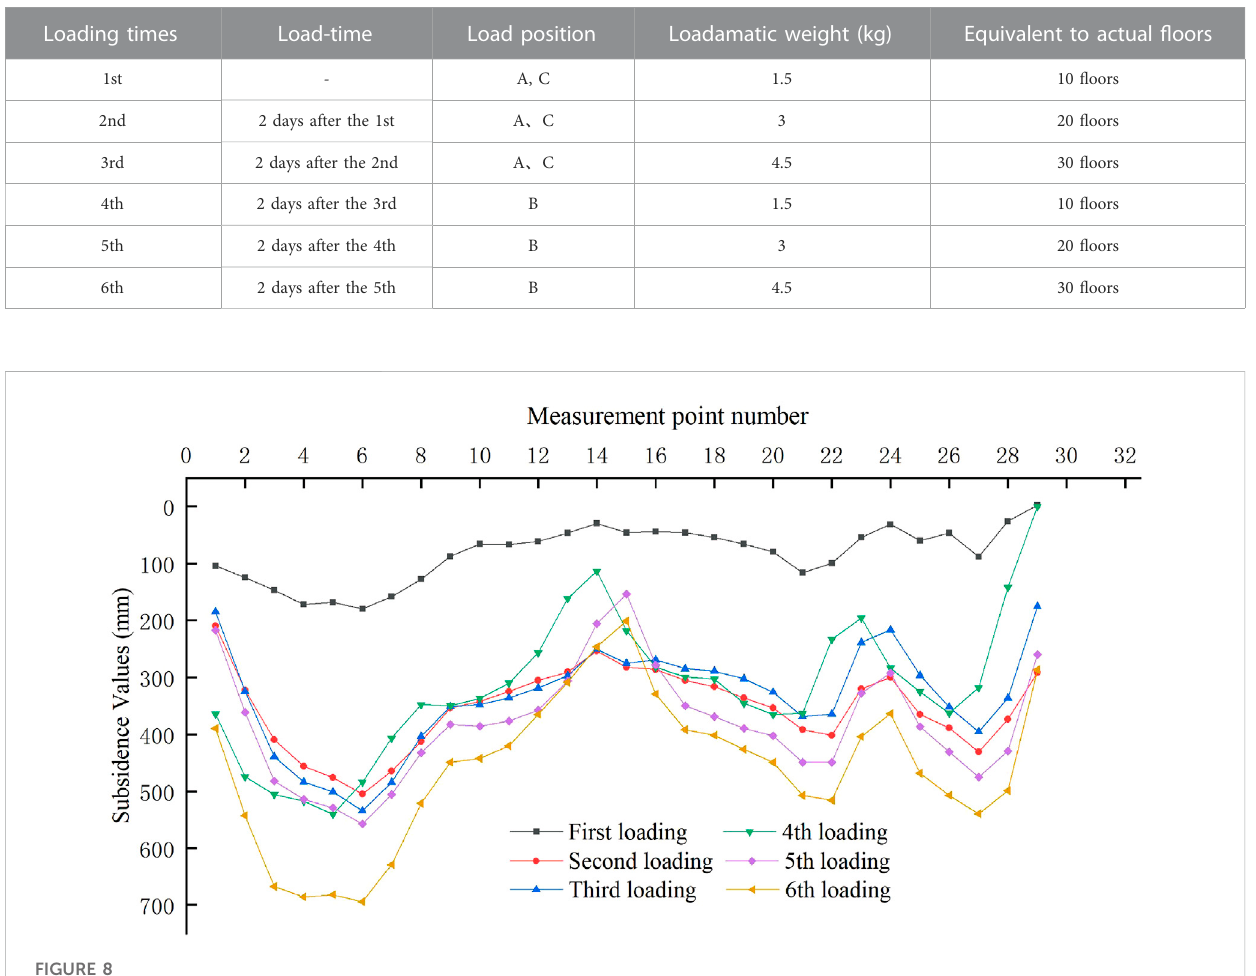
FIGURE 8 Surface subsidence curve after loading.